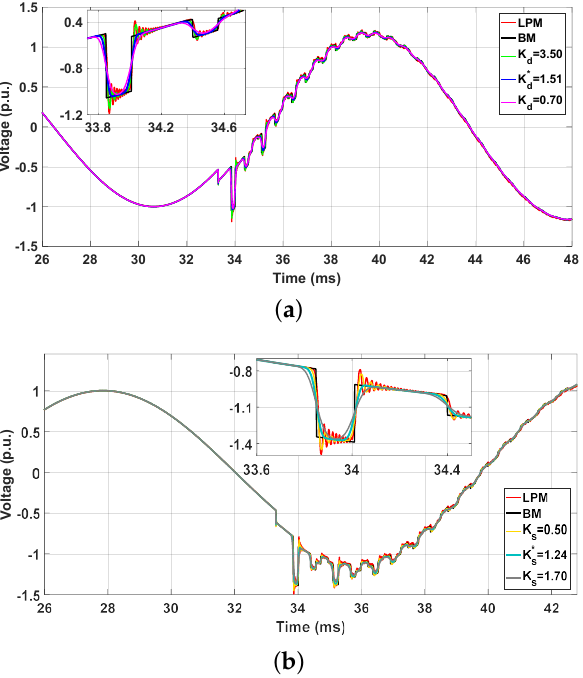
Figure 17. Transient voltages under an earth-fault with LPM, T 1 and BM: ( a ) Phase 2 and ( b ) Phase 3. In general, the modified topologies behave as low-pass filter circuits that mitigate the NSO in the transient responses directly in the time domain and are in good agreement with those transient responses obtained with BM. Furthermore, no digital or analog filters are needed to mitigate the NSO in the computed transient responses when the simulations are carried out with modified topologies. The proposed algorithms are simple tools that can be implemented, and 3-D surfaces with fitted equations are a fast way to calculate the best adjustable factors of each topology. Based on these best adjustable factors, the maximum attenuation of the NSO and minimum distortion in the time-domain transient responses are obtained when low-frequency disturbances occur in TLs. Additionally, these modified topologies are easily incorporated into EMP-type